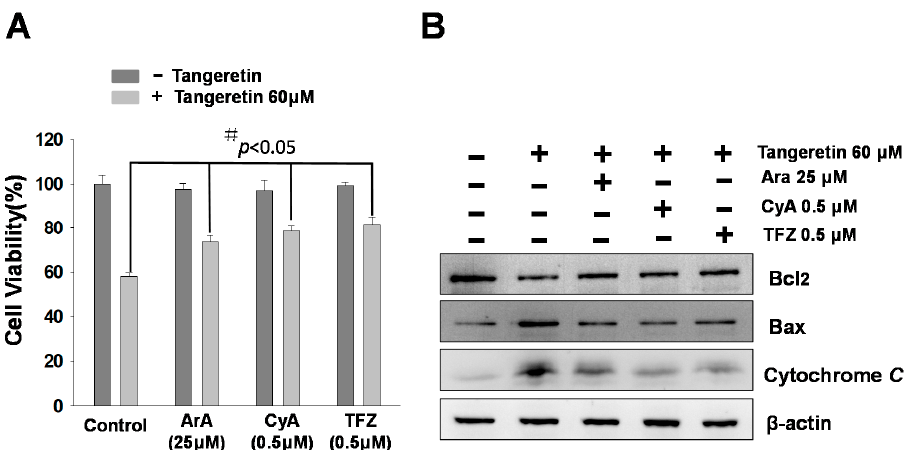
Figure 6. Effect of mitochondrial inhibitors on the cell viability and Bcl-2 family protein expression in tangeretin-treated BFTC-905 cells. ( A ) Cell viability and ( B ) western blotting analysis. Cells were pre-treated with mitochondrial inhibitors trifluoperazine (TFZ), aristolochic acid (ArA), and cyclosporine A (CyA), at the indicated concentrations, followed by 24 h of tangeretin treatment. # p < 0.05.